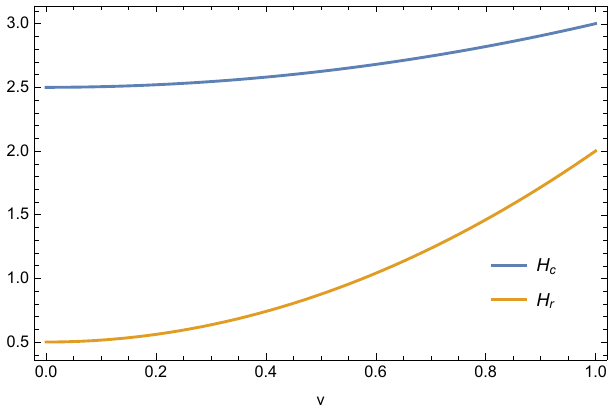
Figure 2. Graphical behaviour of H c ( ν ) and H r ( ν ) of Example 1. Table 1. Numerical validation of Example 1 for p = 0, s =